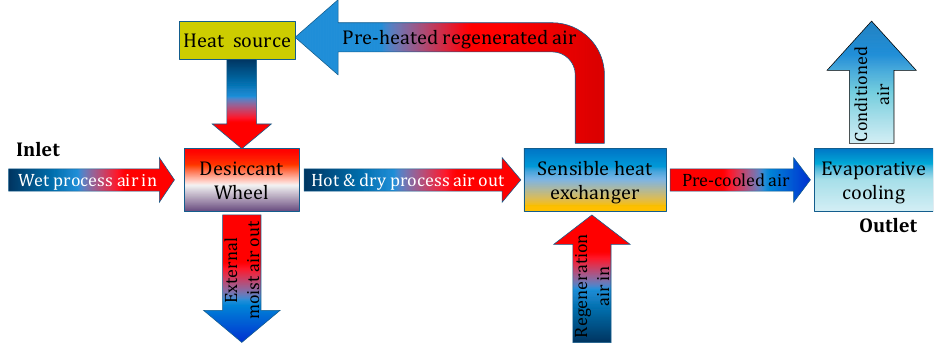
Figure 4. Working principle of a desiccant dehumidification-based evaporative cooling air-conditioning system.